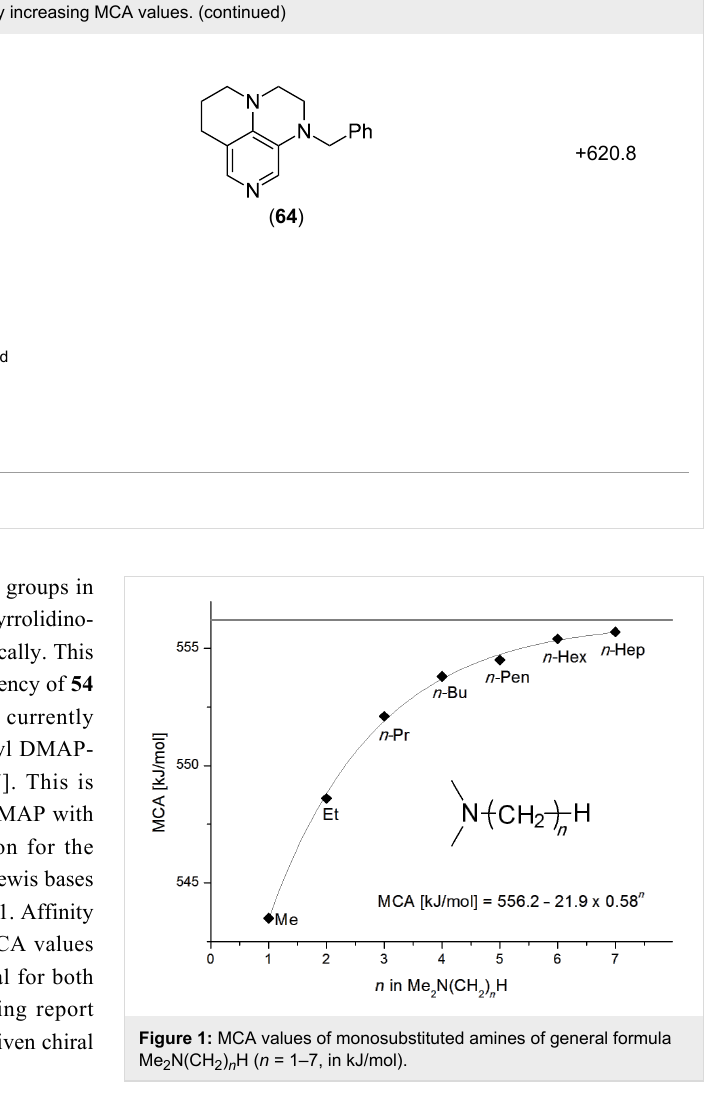
Scheme 2: Systematic dependence of